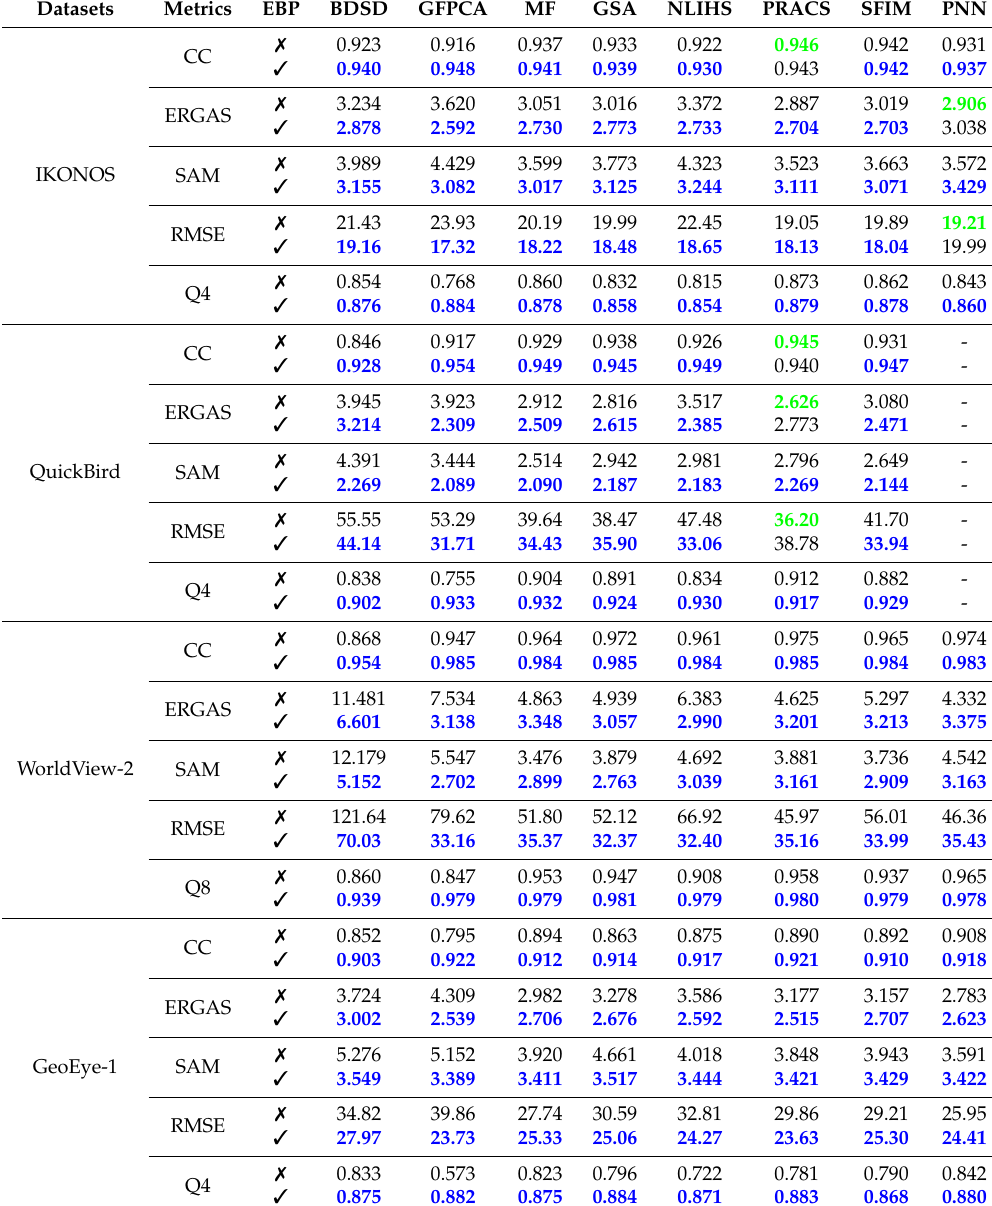
Table 3. Quantitative comparison for the eight methods without (denoted by (cid:55) ) and with (denoted by (cid:51) ) postprocessing by our proposed EBP on four kinds of satellite datasets in the reduced scale. Note that, for better comparison, the results improved by EBP are highlighted in blue, otherwise the original results are colored in